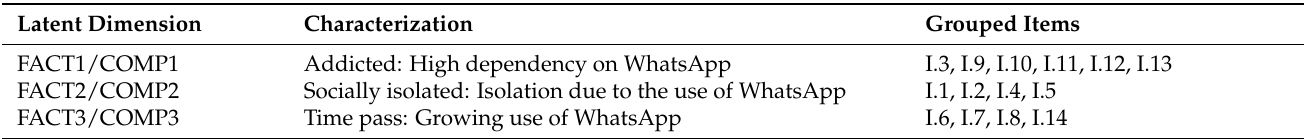
Table 10. Summary of dimensional reduction